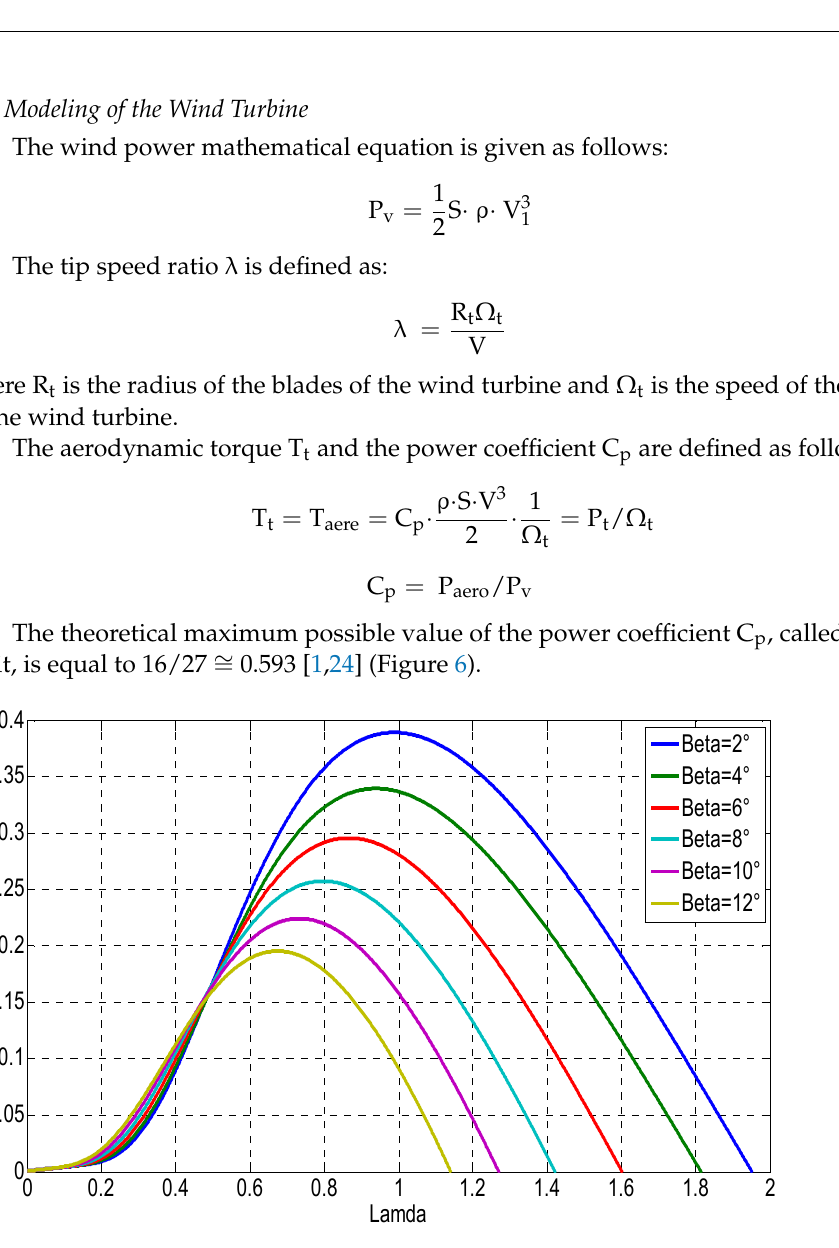
Figure 6. Power coefficient C p as a function of the tip speed ratio λ and the pitch angle β .